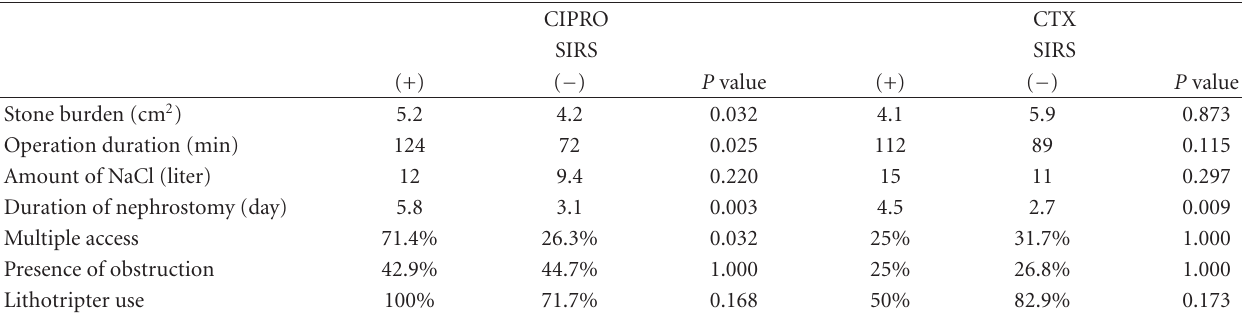
Table 2: Comparison of the predictive factors a ff ecting SIRS positivity among antibiotic groups.